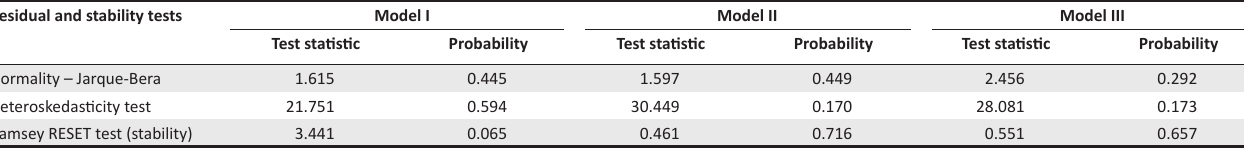
TABLE 9: Diagnostic test results.